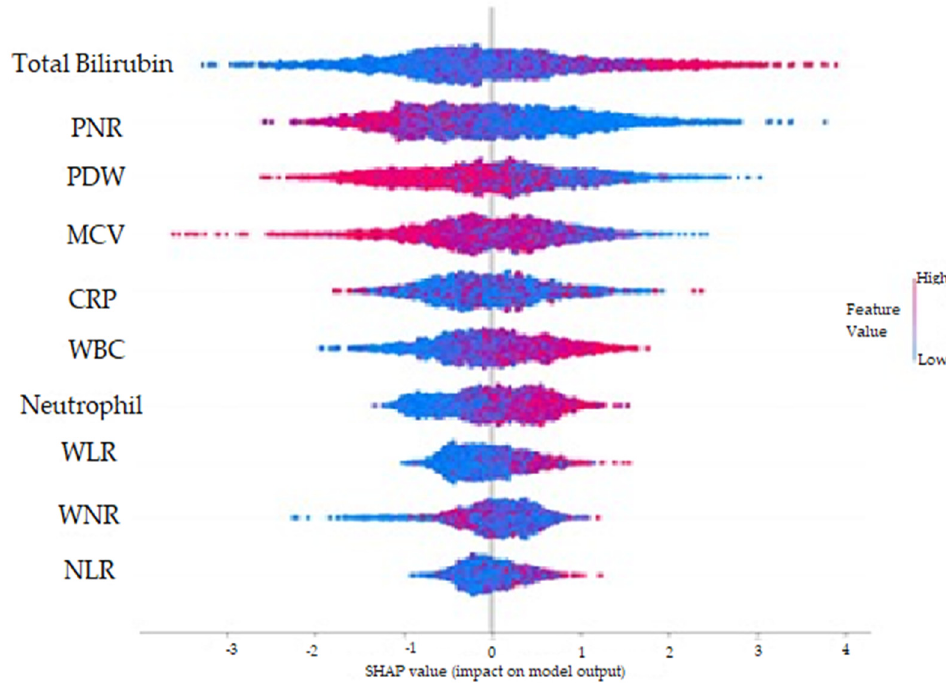
Figure 2. Feature importance plot according to normalized SHAP values for AAp.